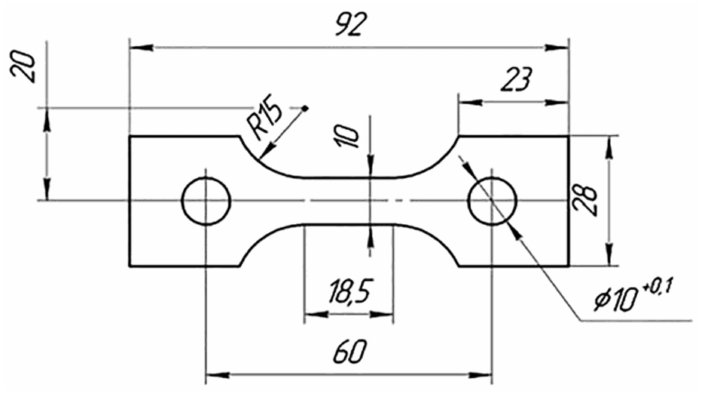
Figure 1. Test specimen, units: mm.